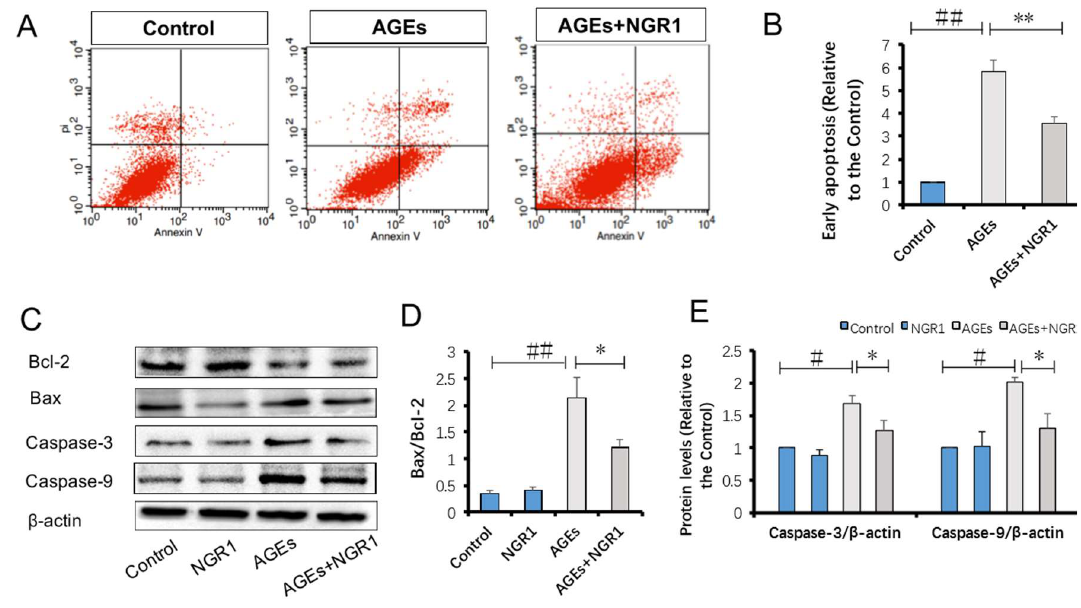
Figure 9. NGR1 suppressed HK-2 cell apoptosis induced by AGEs; ( A , B ) annexin V/propidium iodide (PI) staining, quantitated by flow cytometry analysis; ( C ) Western blot analysis of B-cell lymphoma 2 (Bcl-2), Bcl-2-associated X protein (Bax), caspase-3, and caspase-9 expressions; ( D ) relative expression levels of Bax/Bcl-2, caspase-3, and caspase-9 compared to β -actin are expressed in the bar graphs. All data are presented as the mean ± SD ( n = 3). # p < 0.05 or ## p < 0.01 vs. the control group; * p < 0.05 or ** p < 0.01 vs. the AGE group.